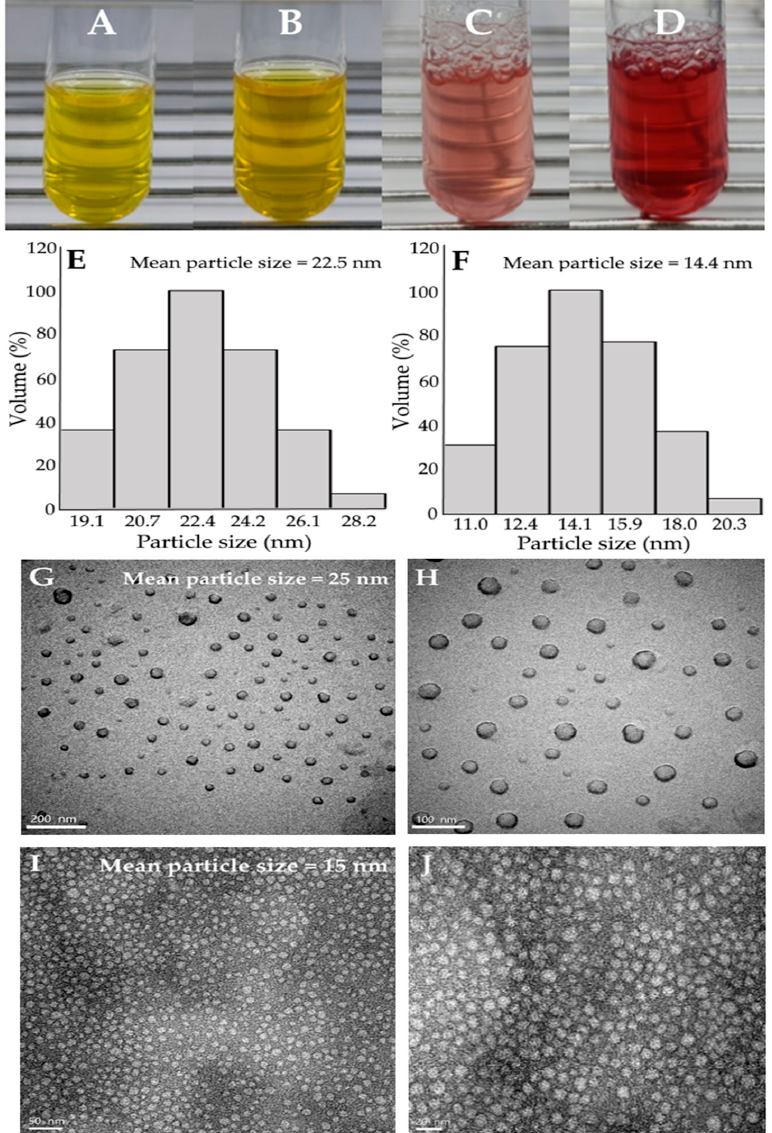
Figure 4. Appearance ( A – D ), particle size distribution ( E , F ) and TEM image ( G – J ) of xanthone nanoemulsion ( A , B , E , G , H ) and anthocyanin nanoemulsion ( C , D , F , I , J ). Xanthone nanoemulsion was prepared with a concentration of 4000 μ g/mL ( A ) and 8000 μ g/mL ( B ), while anthocyanin nanoemulsion was prepared with a concentration of 200 μ g/mL ( C ) and 400 μ g/mL ( D ). Comparatively, the mean particle sizes of xanthone and anthocyanin nanoemulsions prepared in our study were smaller than those reported by Jusril [36] and Bamba et al. [37], with the former using coconut oil, Tween 80, Span 80, and ethyl acetate extract from mangosteen peel to prepare a xanthone nanoemulsion with the mean particle size at 181 nm, and the latter using corn oil, polyglycerol polyricinoleate, and ethanol extract from blueberry pomace to prepare a water-in-oil-in-water anthocyanin nanoemulsion with the mean particle size at 400 nm. Obviously, the difference in mean particle size of the nanoemulsion can be attributed to the variation in oil, surfactant and solvent varieties as well as the extraction method. Additionally, the encapsulation efficiency of xanthone and anthocyanin nanoemulsions was 96.8 and 81.7%, respectively, both of which was higher than that reported by Bamba et al. [37], who prepared a blueberry nanoemulsion from pomace with an encapsulation efficiency of 80% being